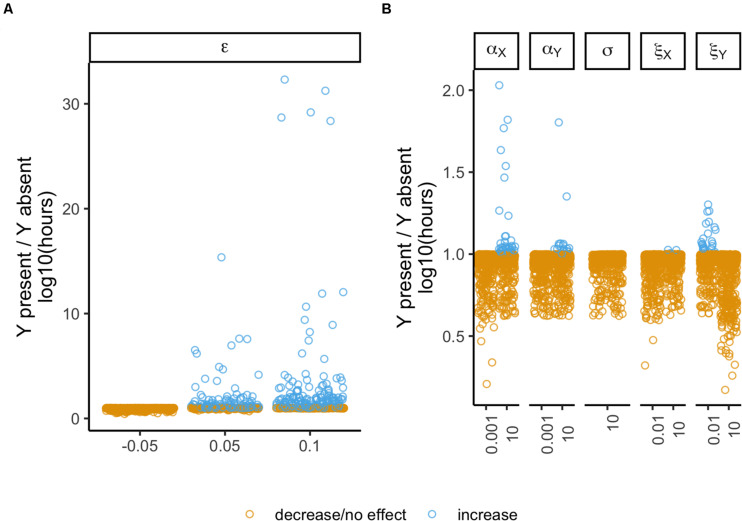
Outcome of the different plasmid interactions. The vertical axis represents the ratio of time of extinction (ToE) when the plasmids interact (models 3–6) by the respective ToE of when the focal plasmid is alone in the population (model 1). The horizontal axis represents the different values of the variable annotated on the top facet. Epistasis (ε) and the remaining parameters are split in different panels to facilitate visualization of the points. Panel (A) represents the effect of epistasis (ε) while panel (B) refers respectively to the following parameters: intracellular interactions affecting the conjugative efficiency of plasmid X (αX) and of plasmid Y (αY), interactions affecting loss rates (δ) and, intercellular interactions affecting the conjugative efficiency of plasmid X (ξX) and of plasmid Y (ξY). Blue dots represent plasmid combinations where the interactions increase ToE relatively to when the plasmid was alone in the population, while yellow dots represent no change or a decrease in ToE.